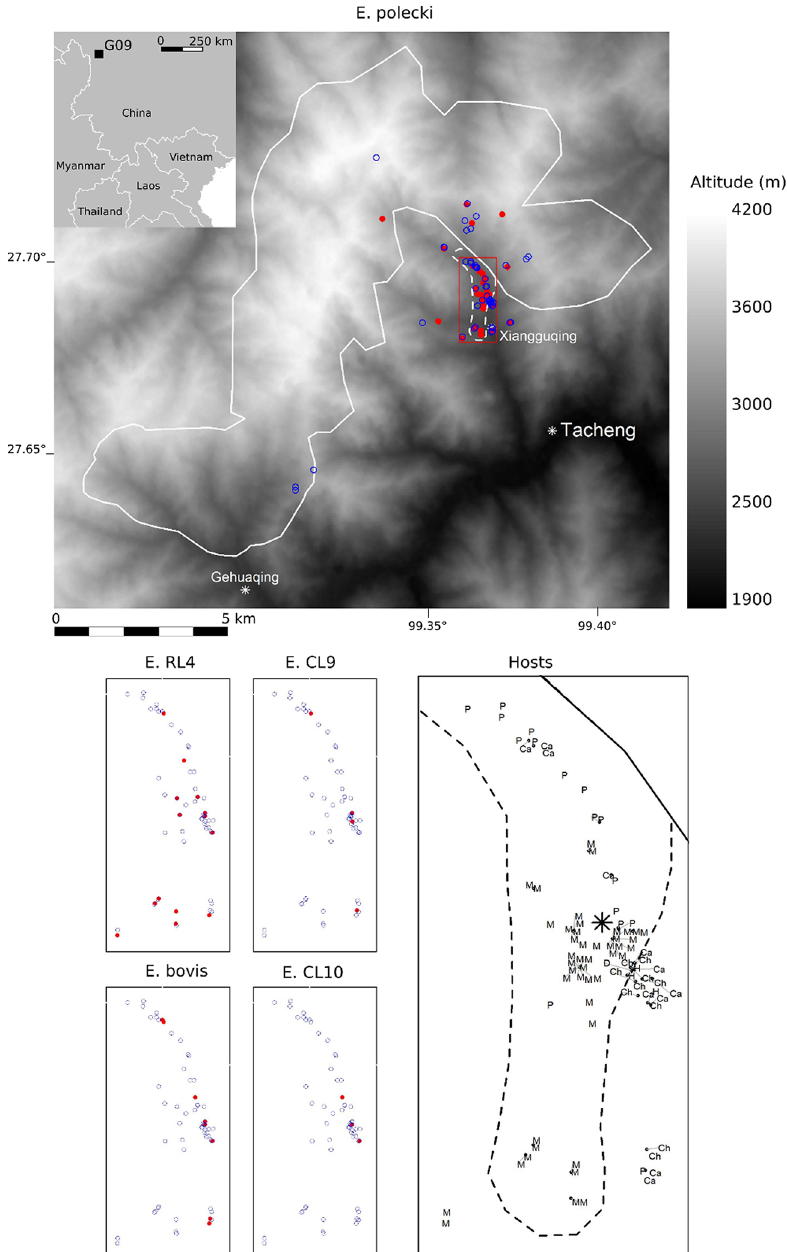
Figure 1. Location of the Xiangguqing/Gehuaqing group and distribution of host and Entamoeba species or lineages. Solid line, limit of the group after Wong et al. (2013), dotted line, limit of the area where monkeys are fed; Red solid circles, positive faeces; blue circles, negative faeces; star, non-monkey faeces centroid; M, monkey; Ca, Cattle; Ch, Chicken; D, dog; H, Human; P;